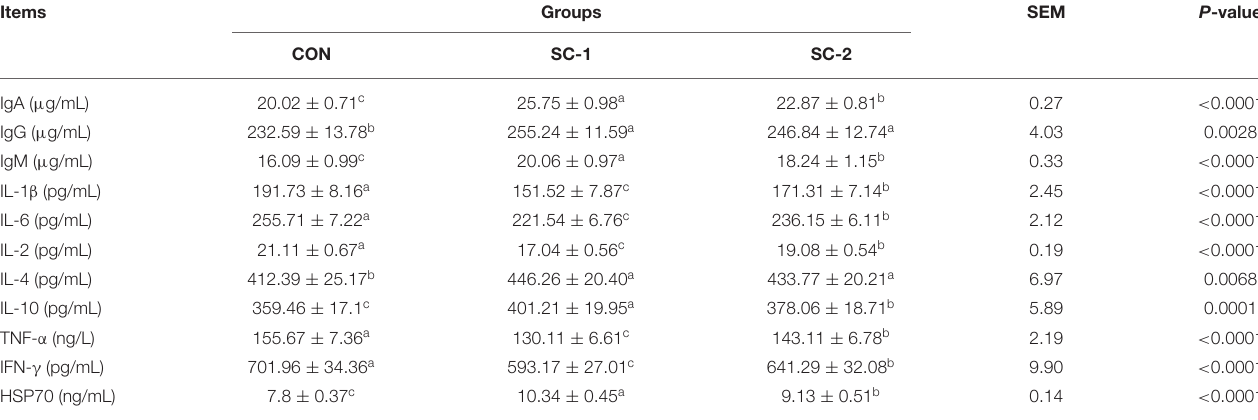
TABLE 8 | Effect of different Saccharomyces cerevisiae cultures on serum immune indices in dairy cows. Items Groups